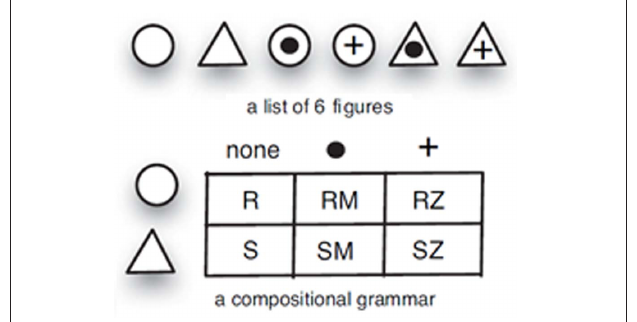
Figure 4 | example of a partially compositional grammar elicited by Kirby et al.’s (2008) iterated learning task. The string associated with a picture consists of substrings expressing color (n, l, r), shape (ere, eho, eki), and motion (ki, plo, pilu) respectively. The hyphens were added for clarification and were not present in the words produced by the original participants. (From Kirby et al., 2008).